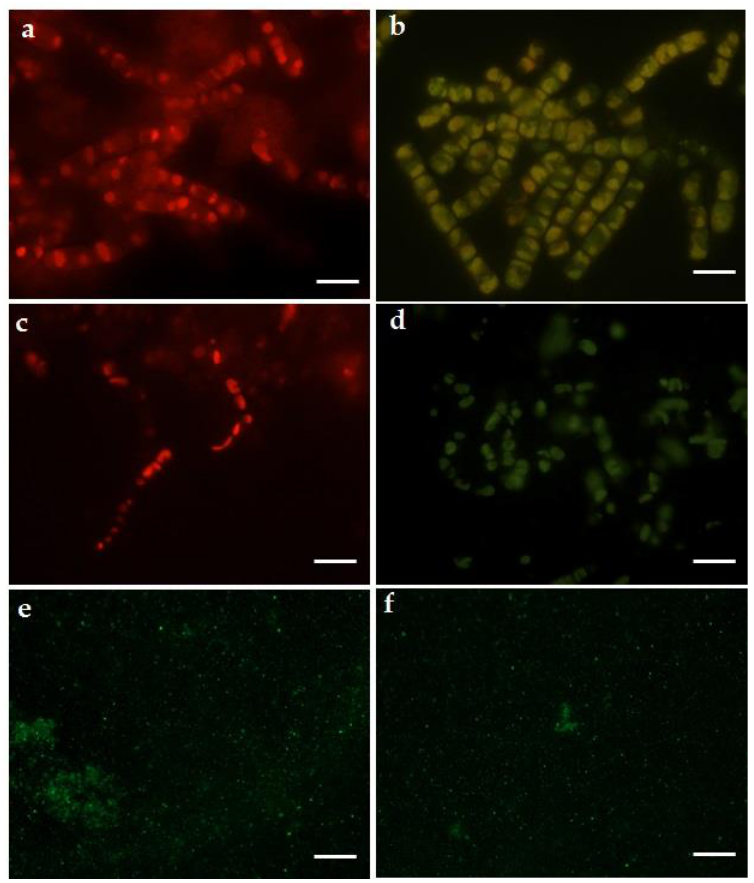
Figure 10. Fluorescent images of control ( a , c ) and Ag treated ( b , d ) G . flavovirens and G . mutabilis respectively. Fluorescent images of Ag-SiO 2 nanohybrid synthesized by G . flavovirens ( e ) and G . mutabilis ( f ) [scale bar 1 µm].